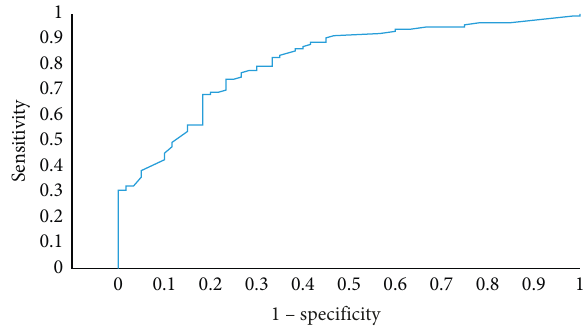
Figure 1: Receiver operating characteristics graph of mortality prediction model.